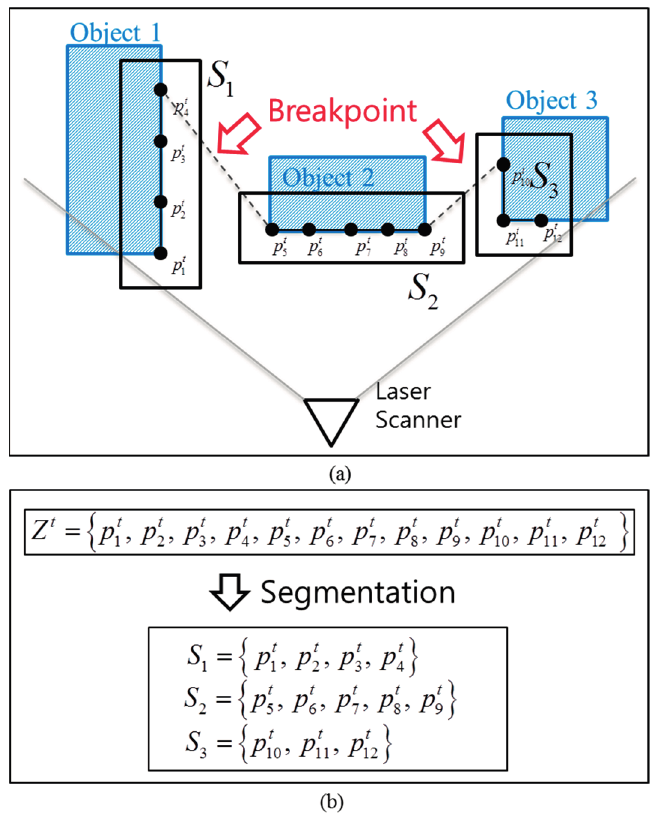
Figure 2. Segmentation by a single-layer laser scanner. ( a ) example of laser scanner measurement; ( b ) result of